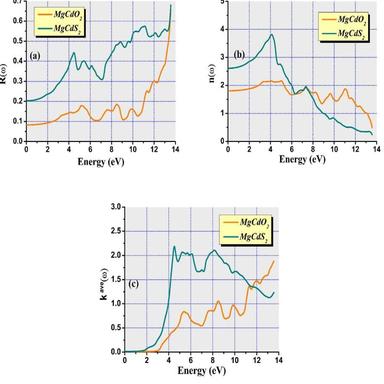
Calculated (a) Reflectivity R(ω), (b) Refractive index n(ω), (c) Extinction coefficient k(ω), for MgCdX2 (X ¼ O, S) materials respectively.